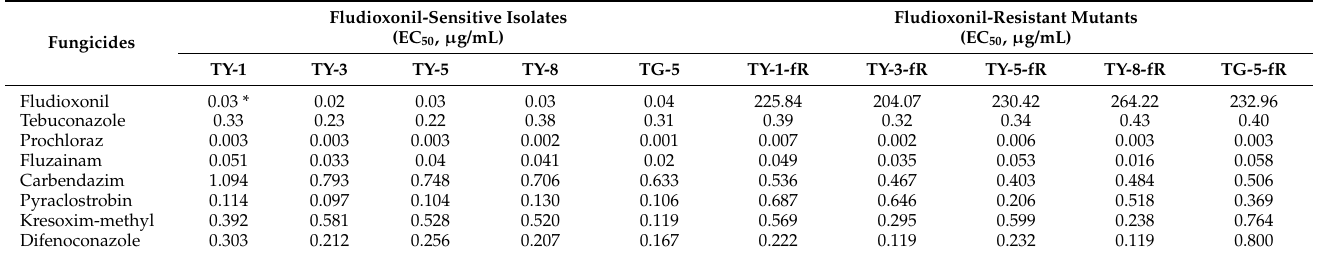
Table 3. Cross-resistance between fludioxonil and other commonly used fungicides.